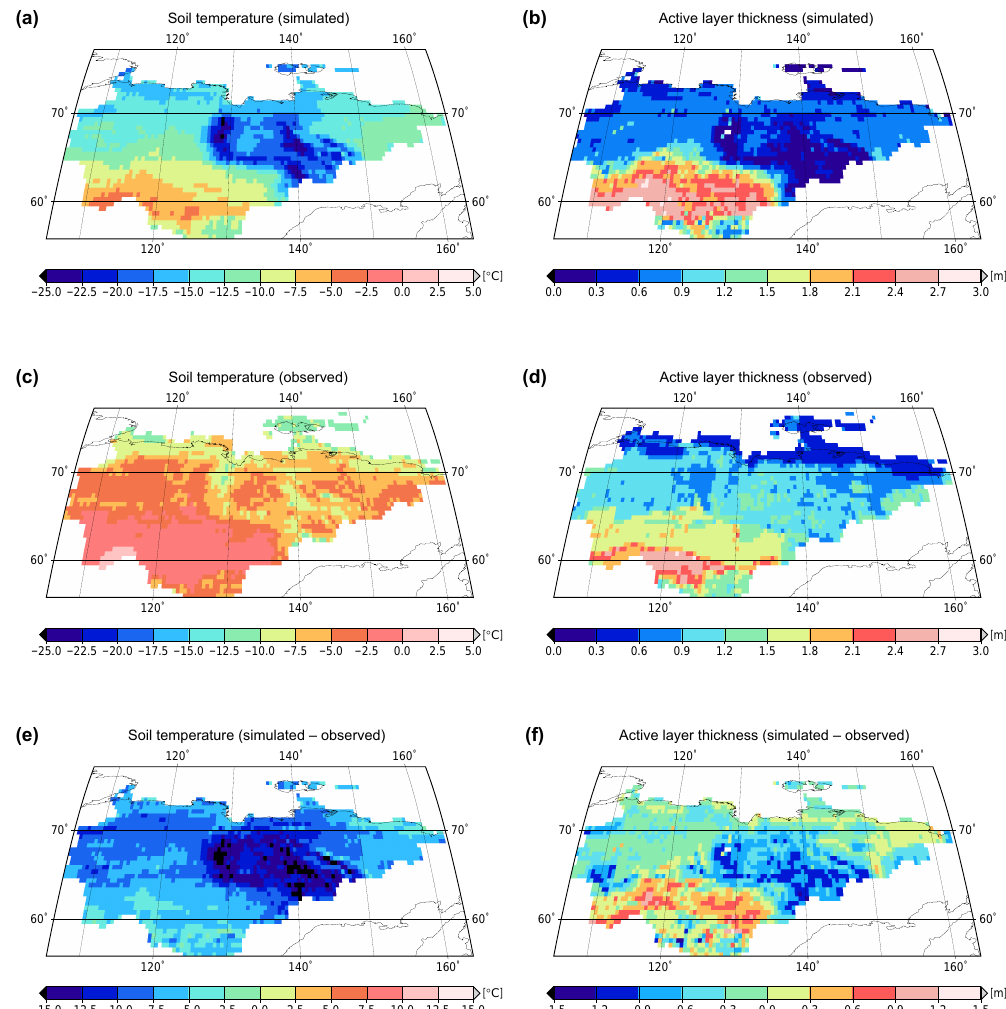
Figure B1. The maps show the spatial patterns of (a) simulated subsoil temperature and (b) active layer thickness, (c) observed subsoil temperature and (d) active layer thickness as well as the differences between simulation and observations regarding (e) subsoil temperature and (f) active layer thickness for the region of Yakutia. The maps (a) and (b) are based on average values over the last 15 years of a transient Dynamic simulation from 1901 to 2010. Subsoil temperature is calculated by averaging the temperatures of the third and fourth soil layer of JSBACH. The observation-based maps in (c) and (d) are taken from Beer et al.